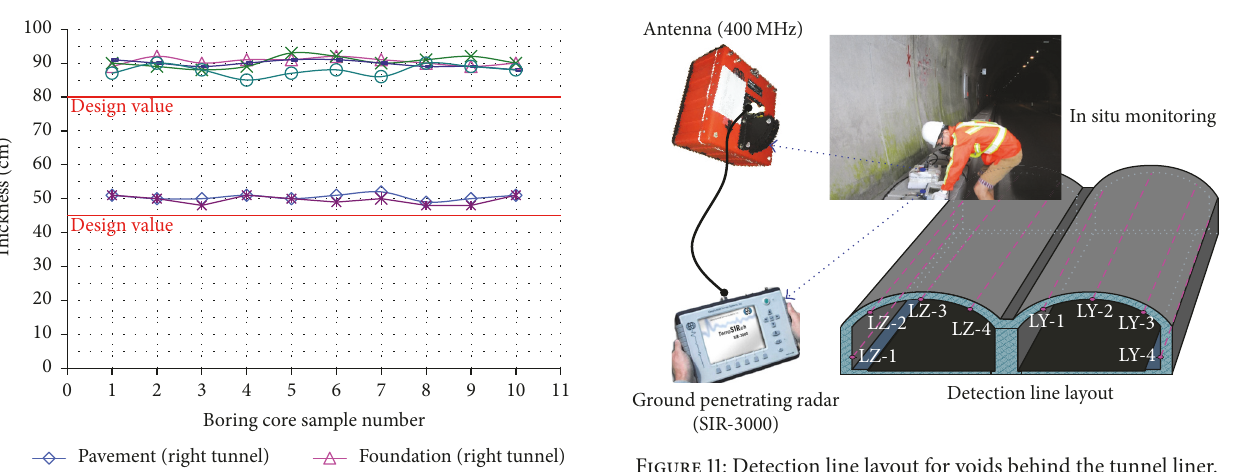
Figure 11: Detection line layout for voids behind the tunnel